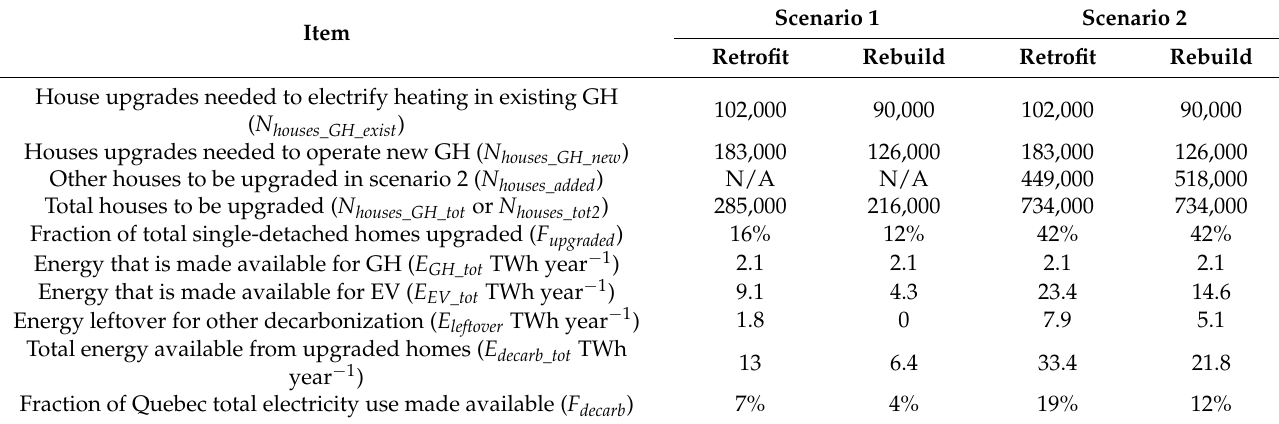
Table 6. Energy that is provided by upgrading enough houses to achieve greenhouse (GH) crop production autonomy (scenario 1) and all houses heated by electric resistance (scenario 2). Scenario 1 Scenario 2 Item Retrofit Rebuild Retrofit